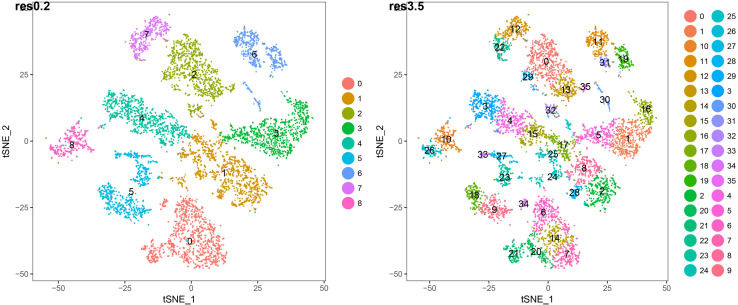
t-SNE plots of 7522 wild-type Arabidopsis root single-cell transcriptomes clustered at two different resolutions. The lower resolution generates 9 major clusters (“superclusters”; roughly representing “cell types”) and the higher resolution generates 36 root cell clusters (RCCs; roughly representing “cell states”). The specific cell type/state assignments for each cluster are provided in Figure 2. Additional details are provided in Supplementary Table 1.